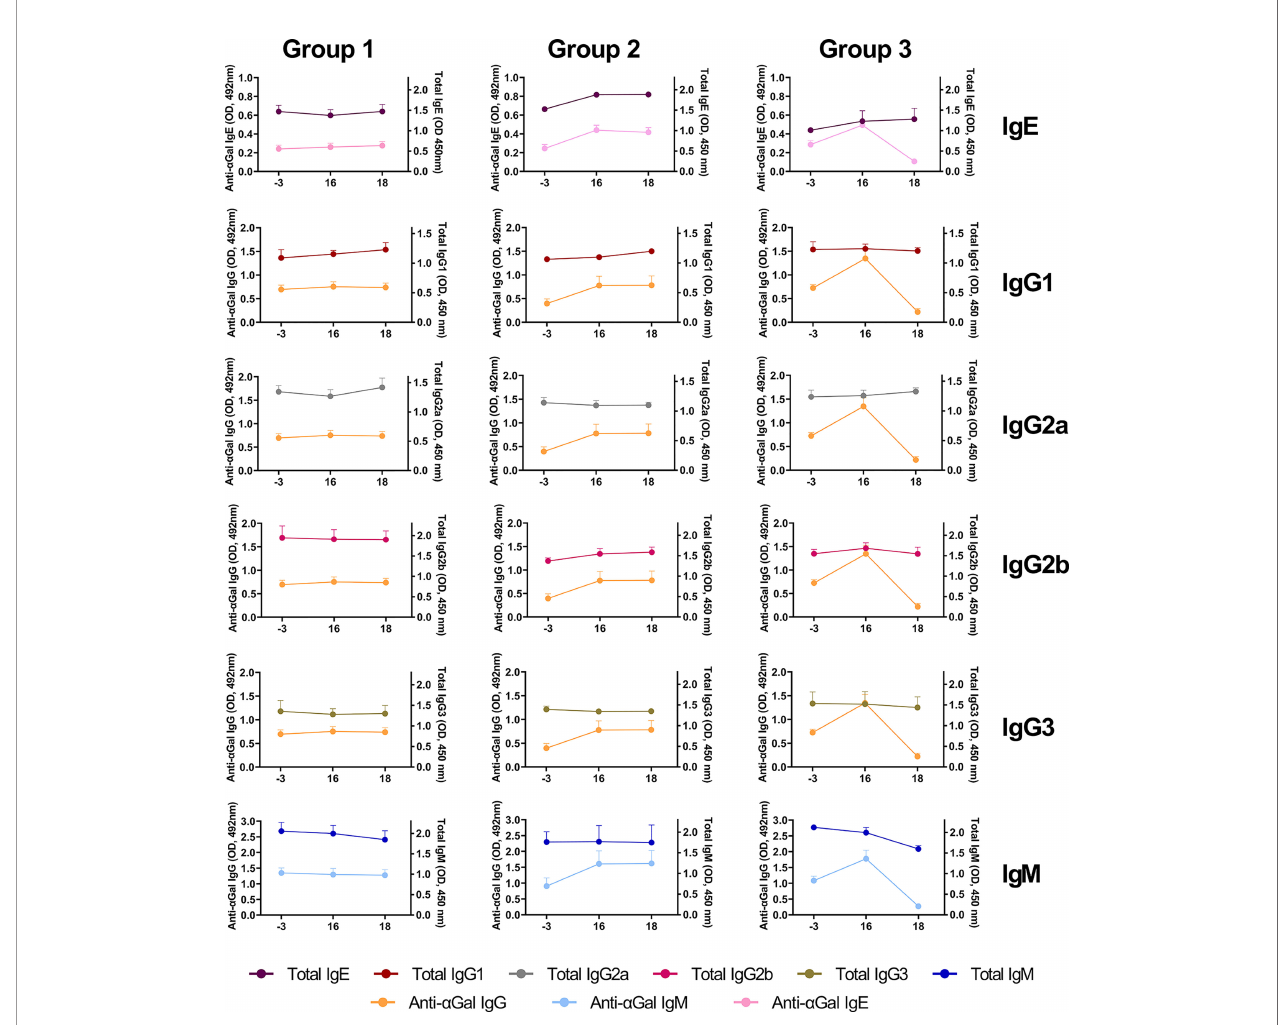
FIGURE 7 | The pattern of total immunoglobulin levels (IgE, IgG1, IgG2a, IgG2b, IgG3, and IgM) and their association with the different isotypes assessed for anti- a Gal antibodies (IgE, IgG, and IgM). Relative serological levels of total immunoglobulins (expressed as OD units, 450 nm) and anti- a Gal antibodies (expressed as OD units, 492 nm) were determined by ELISA on days -3 (baseline), 16 (after sensitization), and 18 (after treatment). GalT-KO mice from Group 1 are a double negative control (PBS for sensitization and treatment, respectively) (n=6). Animals of Groups 2 and 3 were sensitized to a Gal, according to Figure 2 . In Group 3, after sensitization, animals were treated with three consecutive DP1000-RA0118 doses (10 mg/kg, sc.) on days 16, 17, and